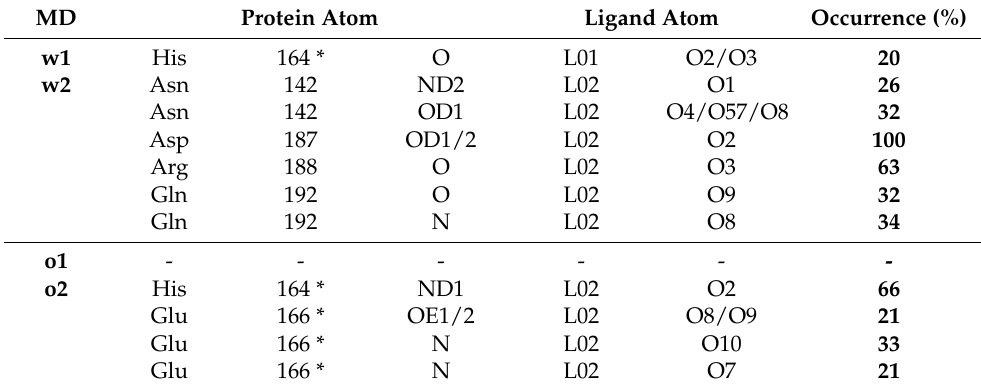
Table 2. Percentage of occurrence of ligand-protein connections along the trajectory frames, for each atomic pair. Only the connections present in more than 20% of the frames are